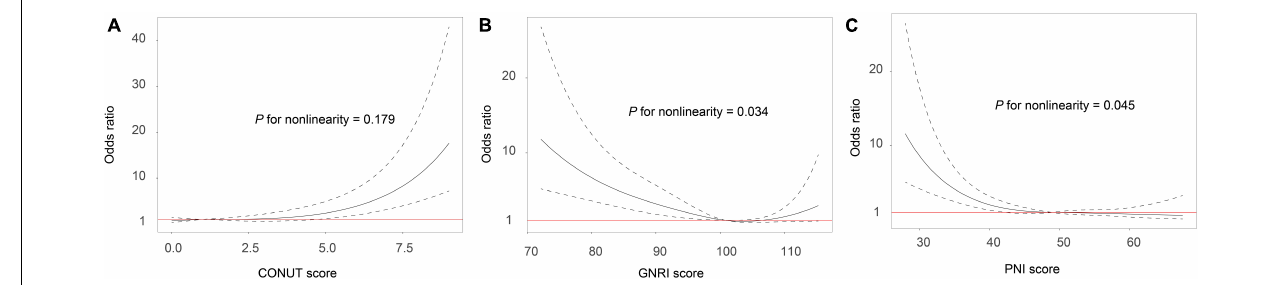
FIGURE 1 | Association between malnutrition and risk of mortality in ischemic stroke patients receiving thrombolytic therapy. Malnutrition was defined by the CONUT score (A) , GNRI score (B) and PNI score (C) . Odds ratios and 95% confidence intervals derived from restricted cubic spline regression, with knots placed at the 5th, 50th, and 95th percentiles of the distribution of the 3 malnutrition indexes. The reference point for malnutrition score is the midpoint of the reference group from the categorical analysis. The odds ratio was adjusted for age, gender, coronary heart disease, baseline NIHSS score, symptomatic intracranial hemorrhage, stroke subtypes, baseline blood glucose, and hypersensitive C-reactive protein levels. CONUT, controlling nutritional status score; GNRI, geriatric nutritional risk index; PNI, prognostic nutritional